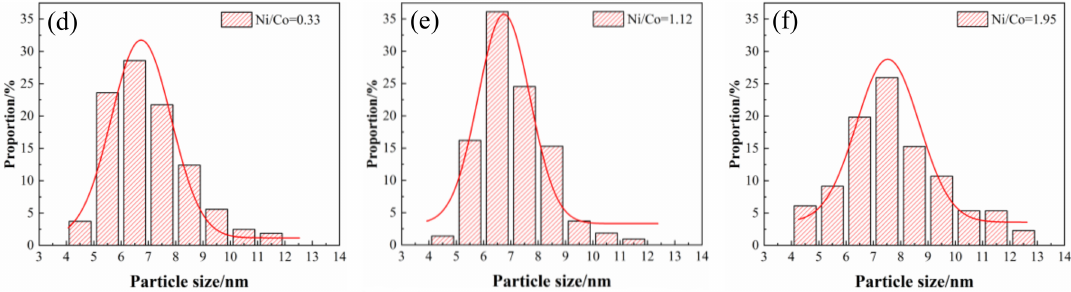
Figure 7. TEM images along [110] Cu and the particle size of alloys with di ff erent Ni / Co mass ratios aged at 500 ◦ C for 1 h; ( a , d ) NC-2, ( b , e ) NC-4, and ( c , f ) NC-5.